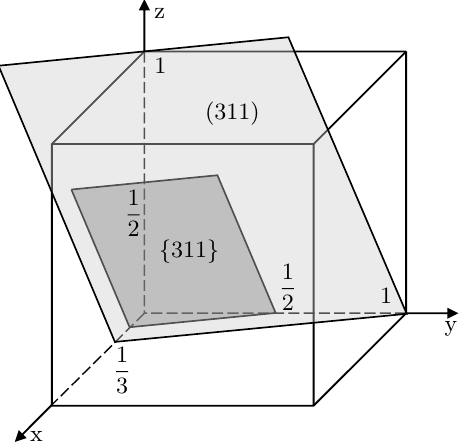
Figure 8. Crystallographic planes {311} considered for residual stress